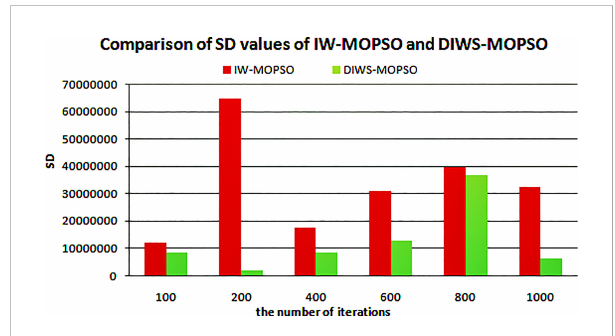
FIGURE 7 SD values comparison of IW-MOPSO and